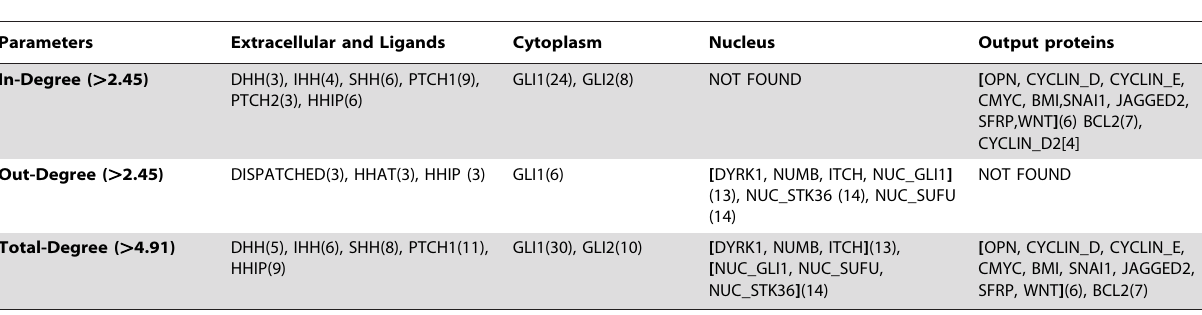
Table 1. Significant proteins extracted from Connectivity